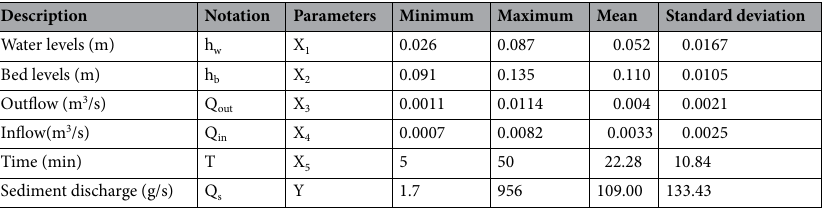
Table1. Statistical characteristics of